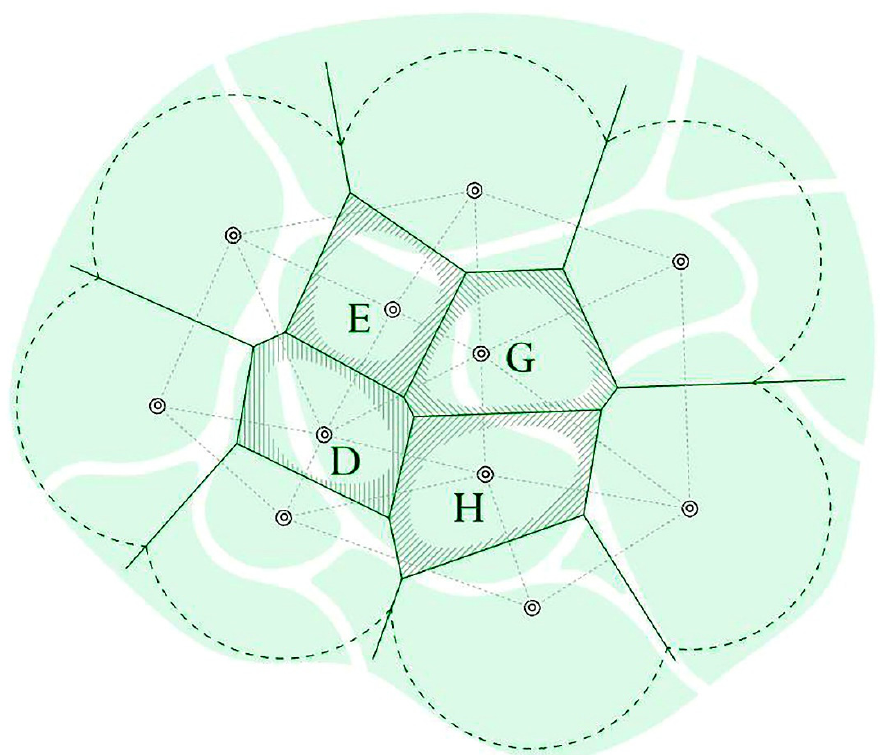
Figure 4. Voronoi Tessellation. Own source.